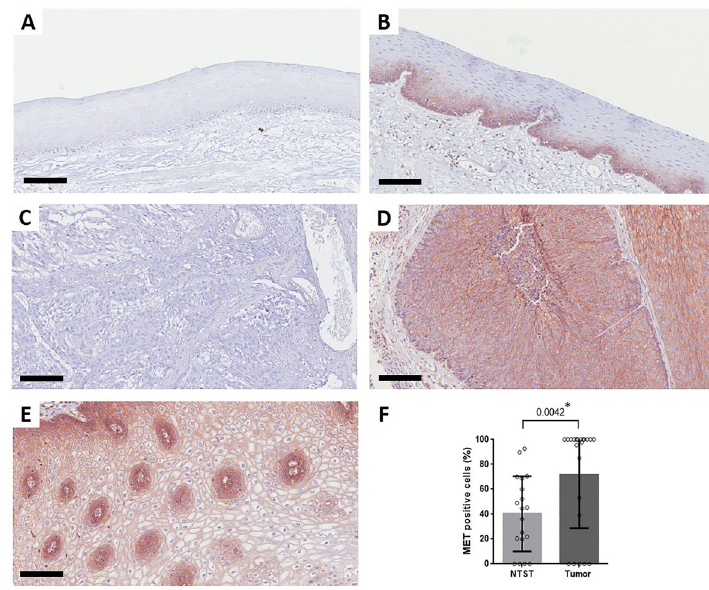
Figure 3. MET immunostaining in esophageal squamous cell carcinoma (ESCC). Representative slides showing a MET-negative ( A ) and a MET-positive ( B ) non-tumor surrounding tissue (NTST) sample, and a MET-negative ESCC sample ( C ). D and E , Representative slides showing MET-positive ESCC samples that showed membrane staining in 100% of the tumor cells. Scale bars, 100 m m. F , Dot-plot showing the percentage of positive cells for MET membrane staining in the NTST (n=22) and ESCC samples (n=25). Data are reported as mean ± SD (Mann Whitney